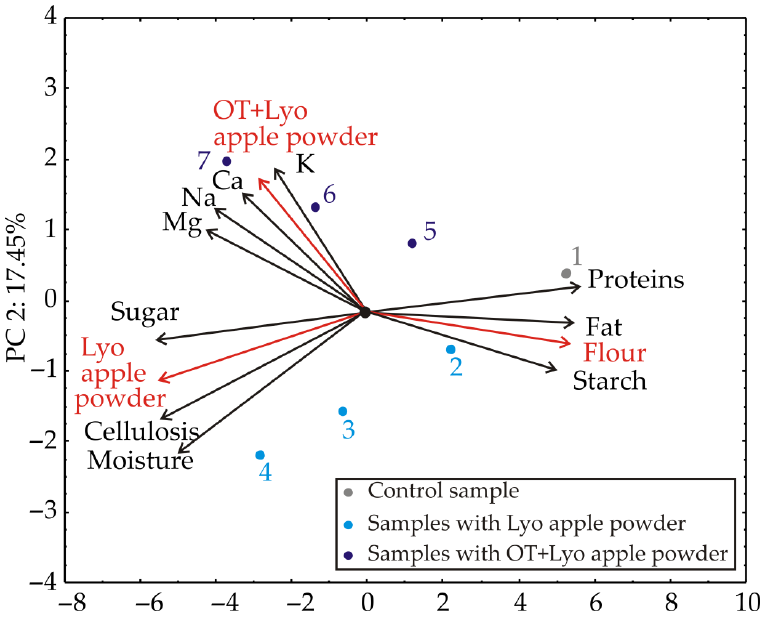
Figure 3. PCA biplot diagram depicting the relationships among muffin samples regarding chemical composition .